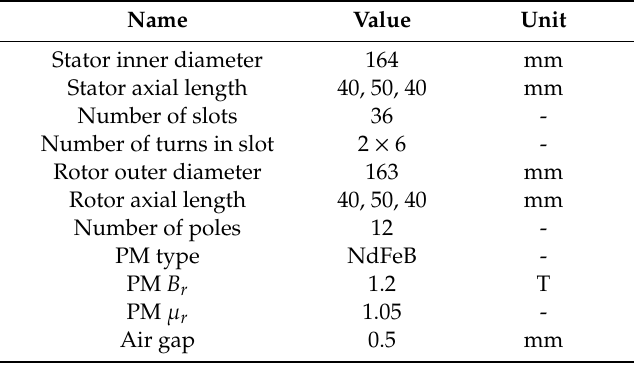
Table 1. The main data of the